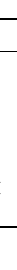
Table 1. Units for magnetic properties.